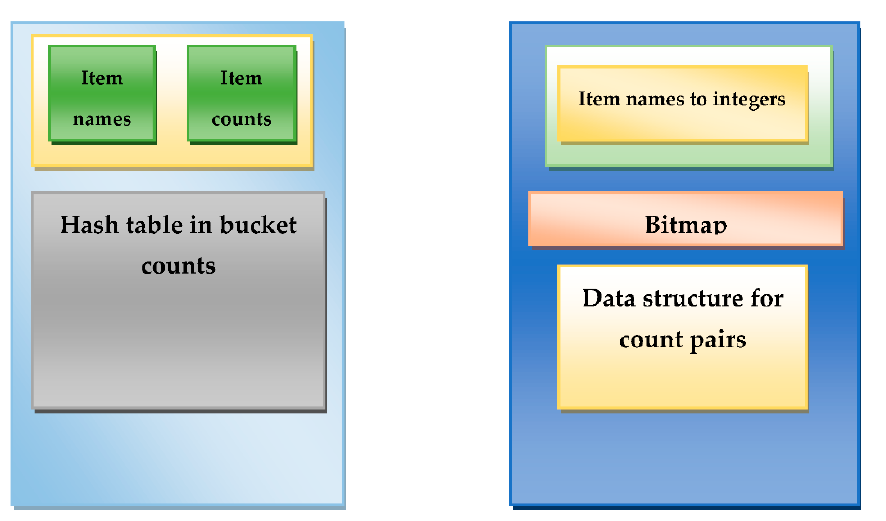
Figure 4. First two passes of the PCY Algorithm.